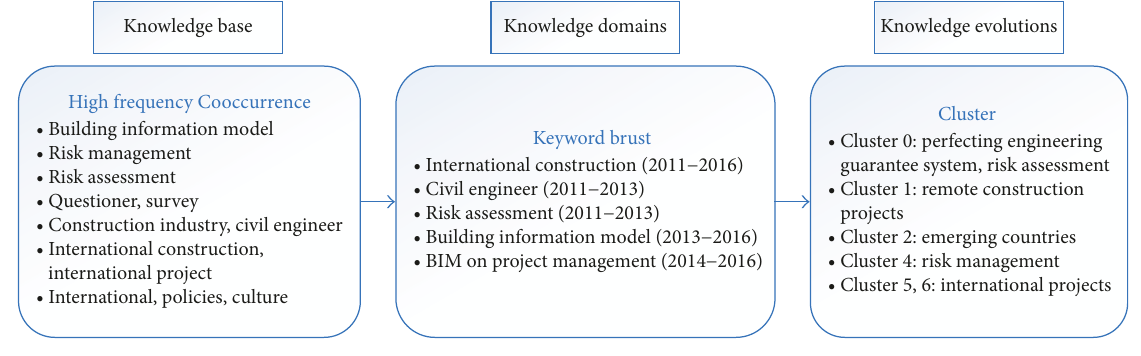
Figure 8: BIM-RM-INTL current research